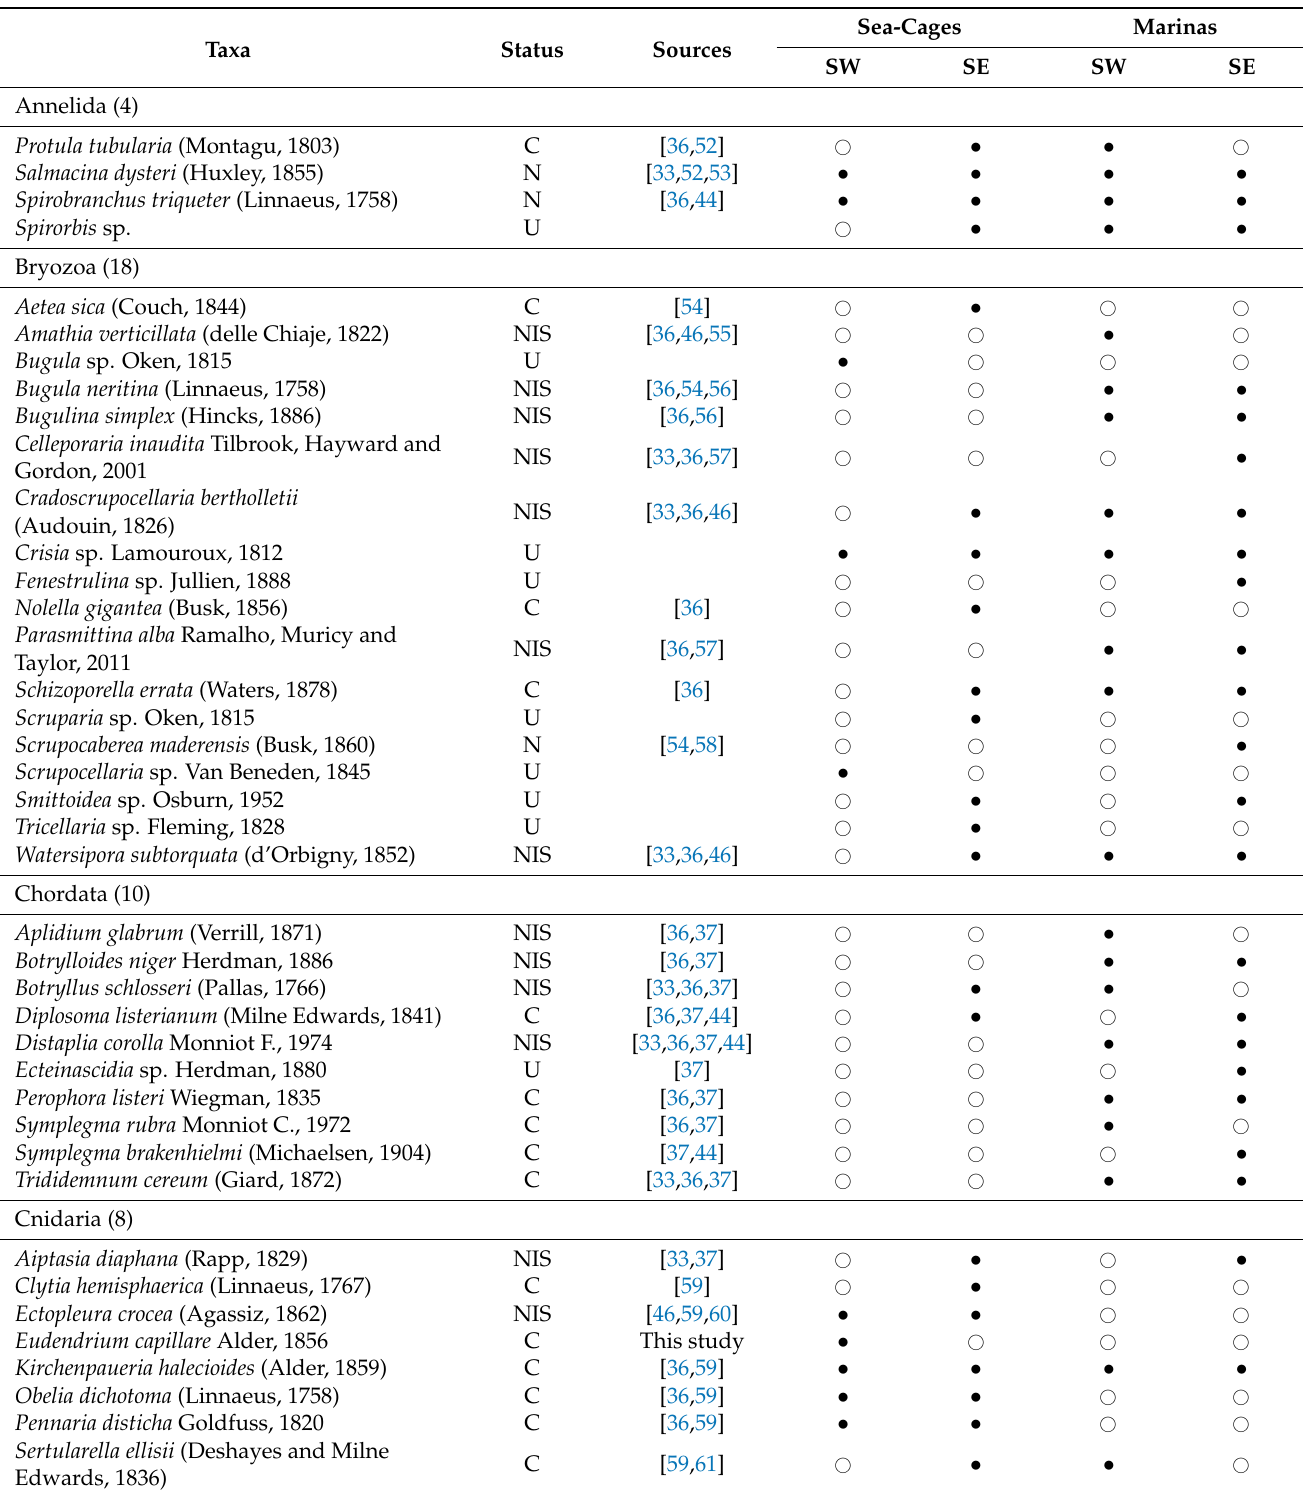
Table 1. List of recorded species found in sea-cages and marinas located on the south coast of Madeira. Taxa were categorized as native (N), non-indigenous species (NIS), cryptogenic (C), or unresolved (U). Filled symbols, present; open symbols,